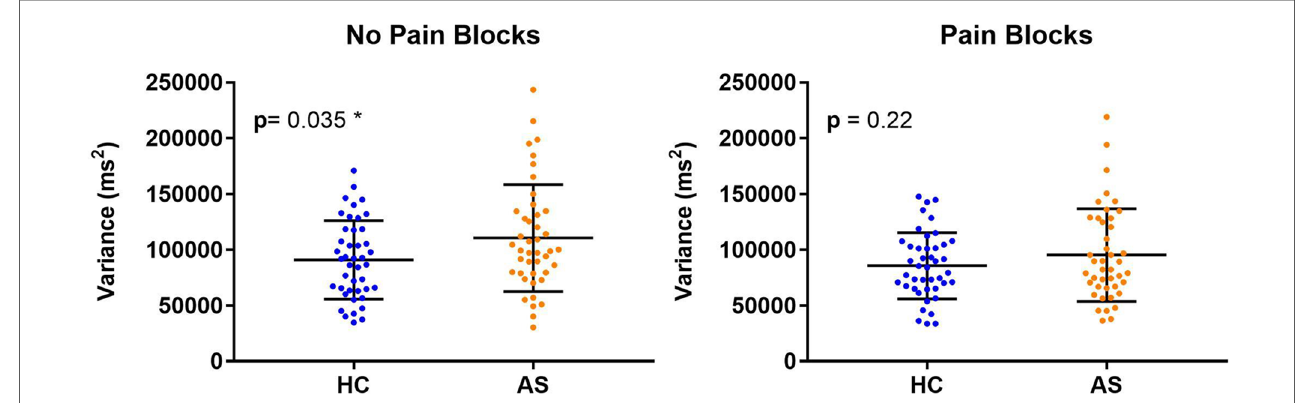
FIGURE 3 Individual and mean group task reaction time variance (RTv). Higher task RTv was found in the healthy controls (HCs) compared to the ankylosing spondylitis (AS) group in the no-pain blocks (left panel) but not in the pain blocks (right panel). The HCs are represented by the blue dots. The AS group is represented by the orange dots.